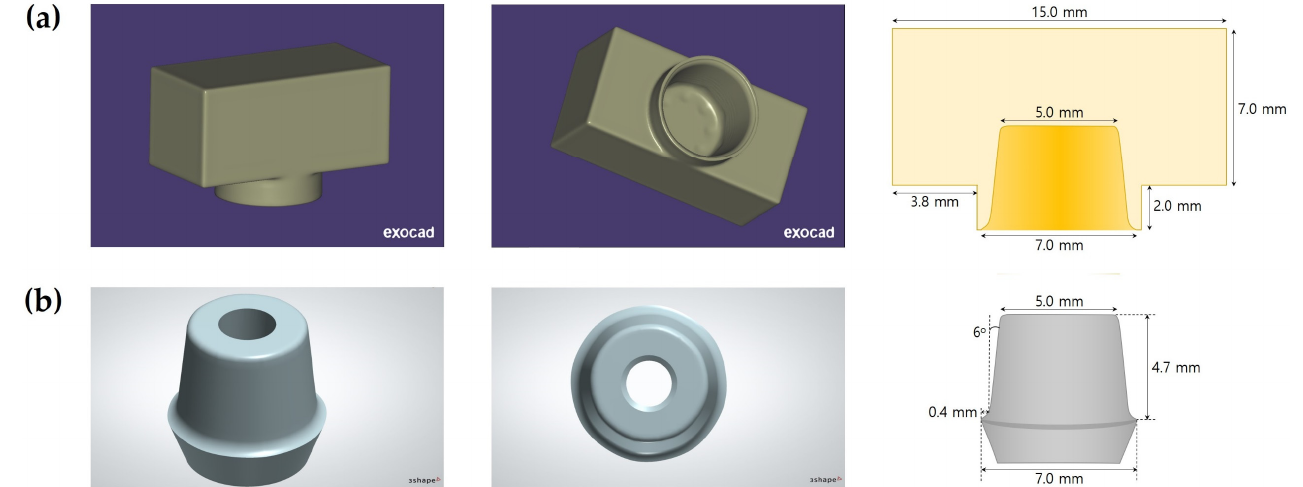
Figure 1. ( a ) CAD design of the zirconia crown and schematic diagram of the cross-section of the zirconia crown. ( b ) CAD design and schematic diagram of the titanium abutment.